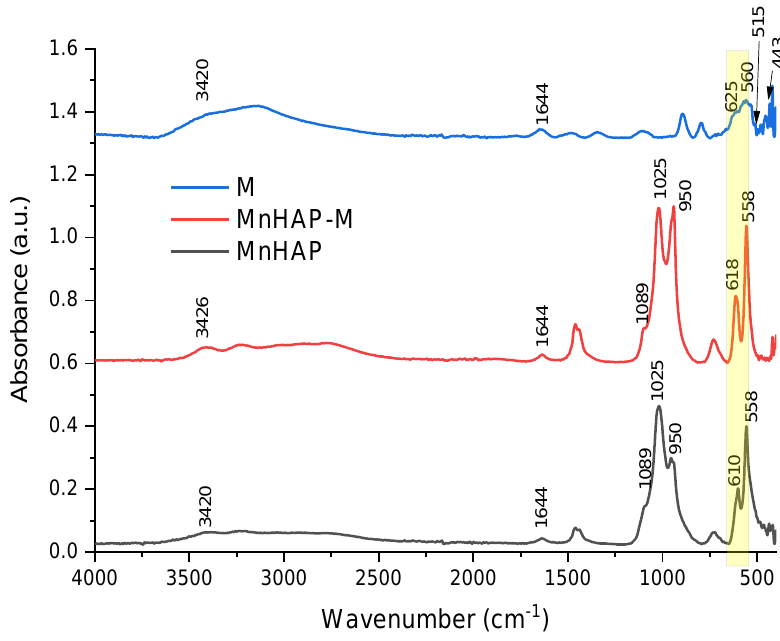
Figure 3. FTIR spectra of the composite material (MnHAP-M), compared with the manganese phosphatic material (MnHAP) and the magnetic iron oxide (M). Peaks further discussed are detailed on the spectra.